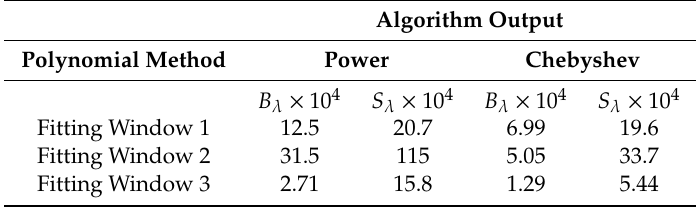
Table 4. Mean bias and RMSD for fitting windows 1 to 3 depending on the polynomial used.